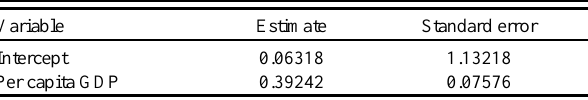
Table 9 . A comparison of support for the top 10 models of social-ecological factors and the proportion of endangered and invasive birds and mammals in 100 different